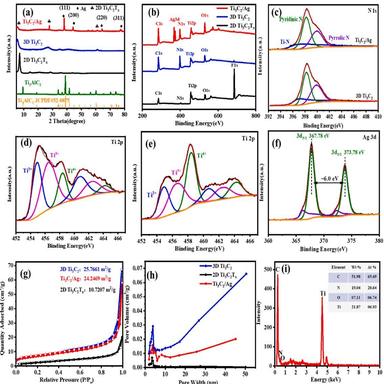
(a) XRD patterns of Ti3AlC2, 2D Ti3C2Tx, 3D Ti3C2 and 3D Ti3C2/Ag; (b) XPS full spectra of 2D Ti3C2Tx, 3D Ti3C2 and 3D Ti3C2/Ag; (c) N 1s High-resolution XPS spectra of 3D Ti3C2 and 3D Ti3C2/Ag; (d) Ti 2p High-resolution XPS spectra of 3D Ti3C2; (e) Ti 2p High-resolution XPS spectra of 3D Ti3C2/Ag; (f) Ag 3d Highresolution XPS spectra of 3D Ti3C2/Ag; (g) N2 adsorption–desorption isotherms (h) Pore size distribution of 2D Ti3C2Tx, 3D Ti3C2 and 3D Ti3C2/Ag; (i) EDS spectra of 3D Ti3C2.